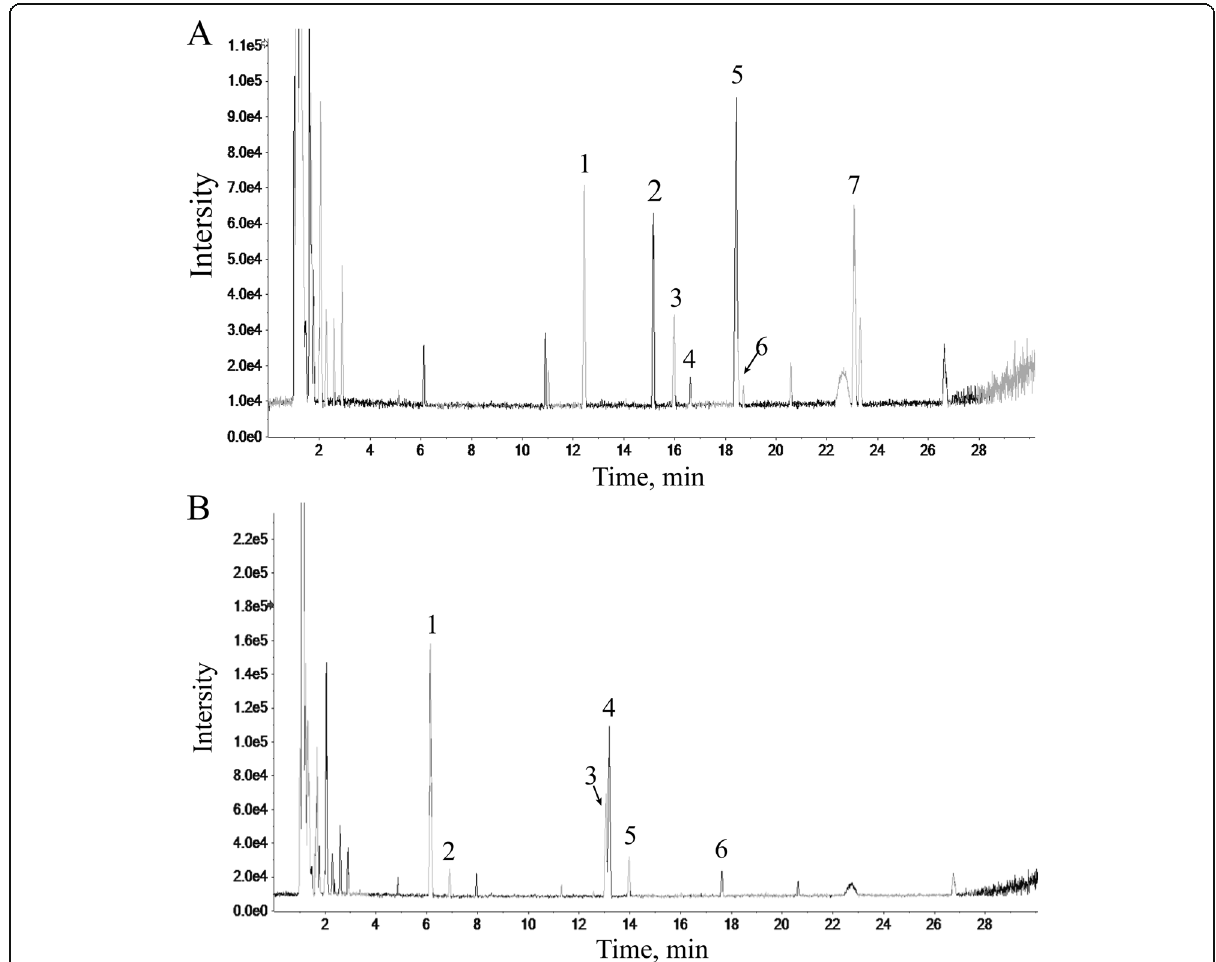
Fig. 1 HPLC-ESI/MS n base peak chromatogram of the total ion chromatogram for the lyophilized powder of Radix Astragali and Radix Angelicae Sinensis aqueous extract. The abscissa represents the retention time, and the ordinate represents the chromatographic peak intensity. ( a ) HPLC- ESI/MS n analysis of Radix Astragali . ( b ) HPLC-ESI/MS n analysis of Radix Angelicae